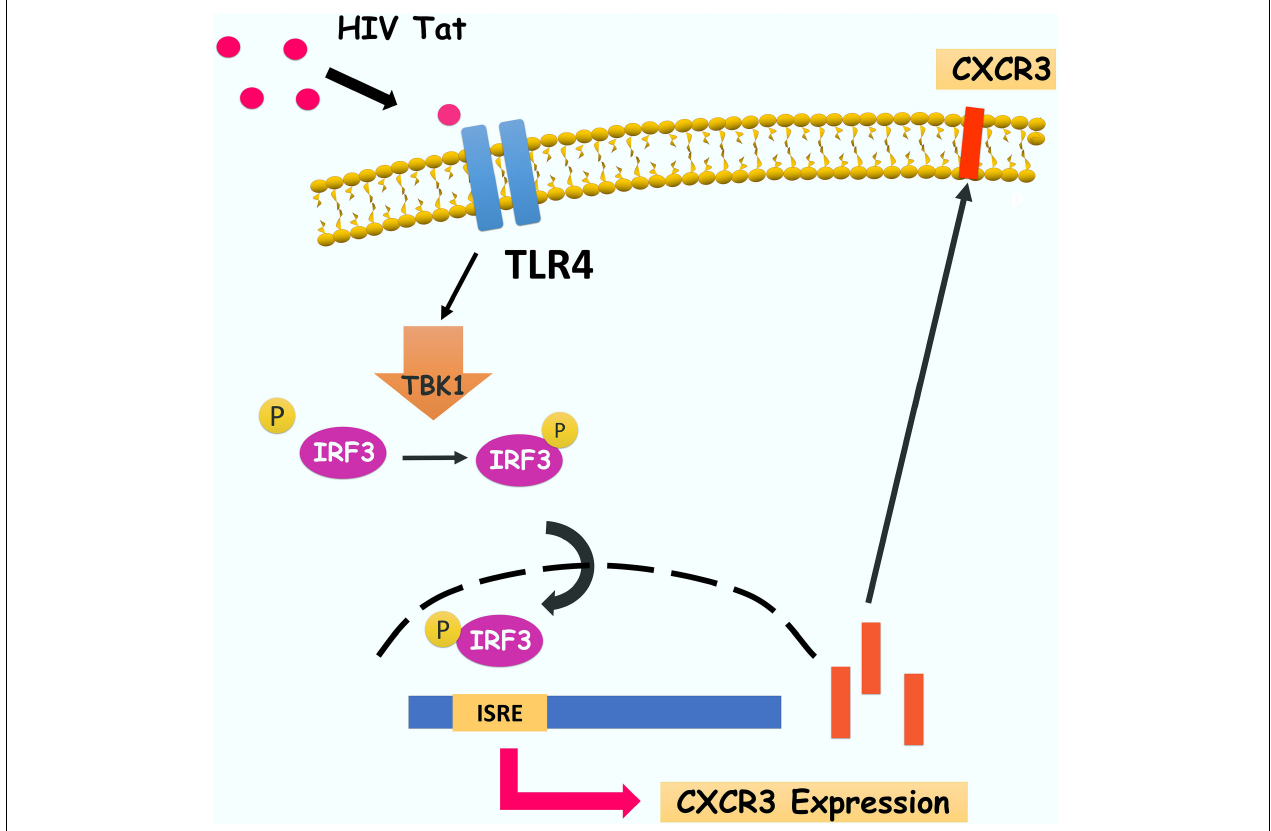
FIGURE 9 | Schematic diagram demonstrating signaling pathways involved in HIV Tat-mediated induction of CXCR3 expression in human monocytes. HIV Tat-mediated TLR4 activation results in phosphorylation of TBK1 and subsequently induces phosphorylation and nuclear translocation of IRF3 which, leading, in turn, increases the binding of IRF3 and CXCR3 promoter and subsequently enhance CXCR3 expression. Increased CXCR3 ultimately leads to increased CXCL10-mediated monocyte transmigration into the brain.